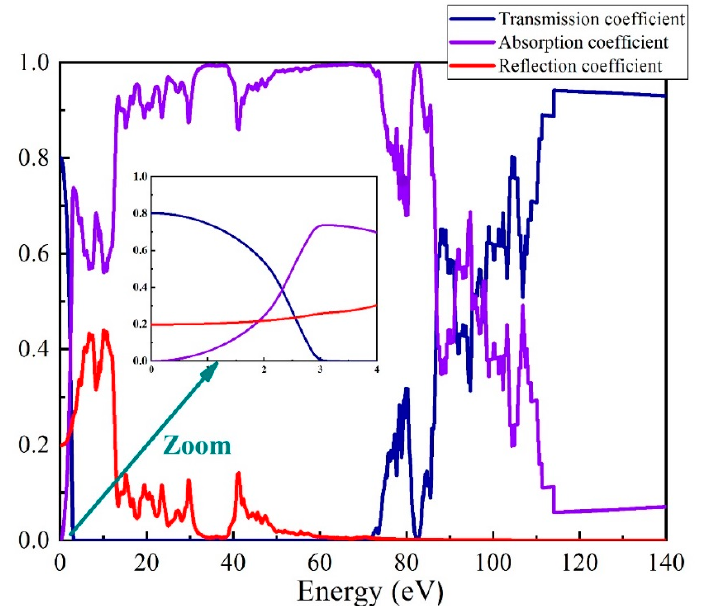
Figure 5. Optical spectrum showing the transmission, reflection and absorption spectrum as calcu- lated with HSE06.